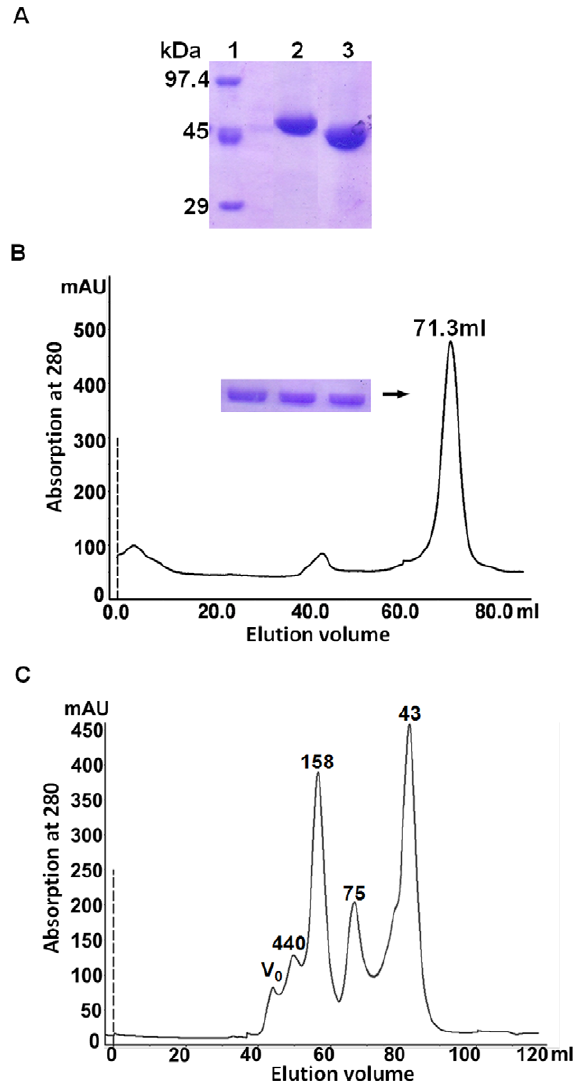
Figure 4. Purification and molecular mass determination of Eh ODC. (A) Affinity purification of Eh ODC showing purified protein in 12% SDS-PAGE. Lane 1: Molecular weight marker; Lane 2: Purified Eh ODC-His tagged protein; Lane 3: Purified His tag cleaved protein with molecular weight , 46 kDa. (B) Size-exclusion chromatography profile of Eh ODC and 12% SDS-PAGE (insert) analysis of major peak fractions. (C) The elution profile of standard molecular weight markers from size exclusion chromatography through HiLoad 16/60 Superdex 200 column. The column void volume (V o ) and molecular weight (kDa) of standard proteins are